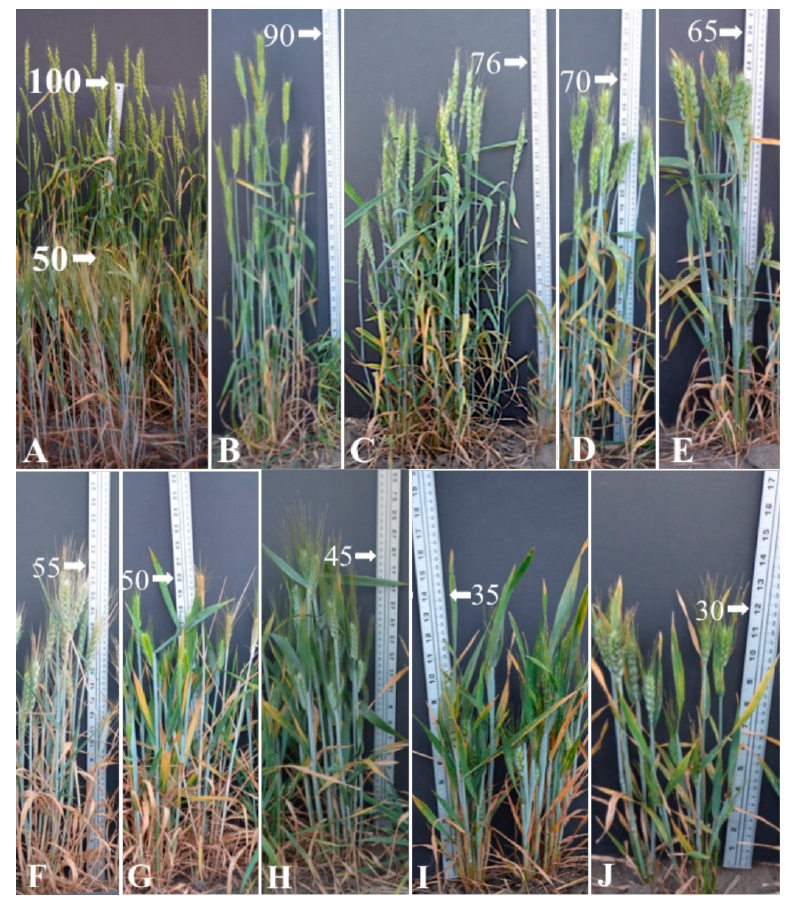
Figure 2. Plant height distribution among F 2:3 families. ( A ) Indian and Icaro; and ( B – H ) different F 2:3 families.